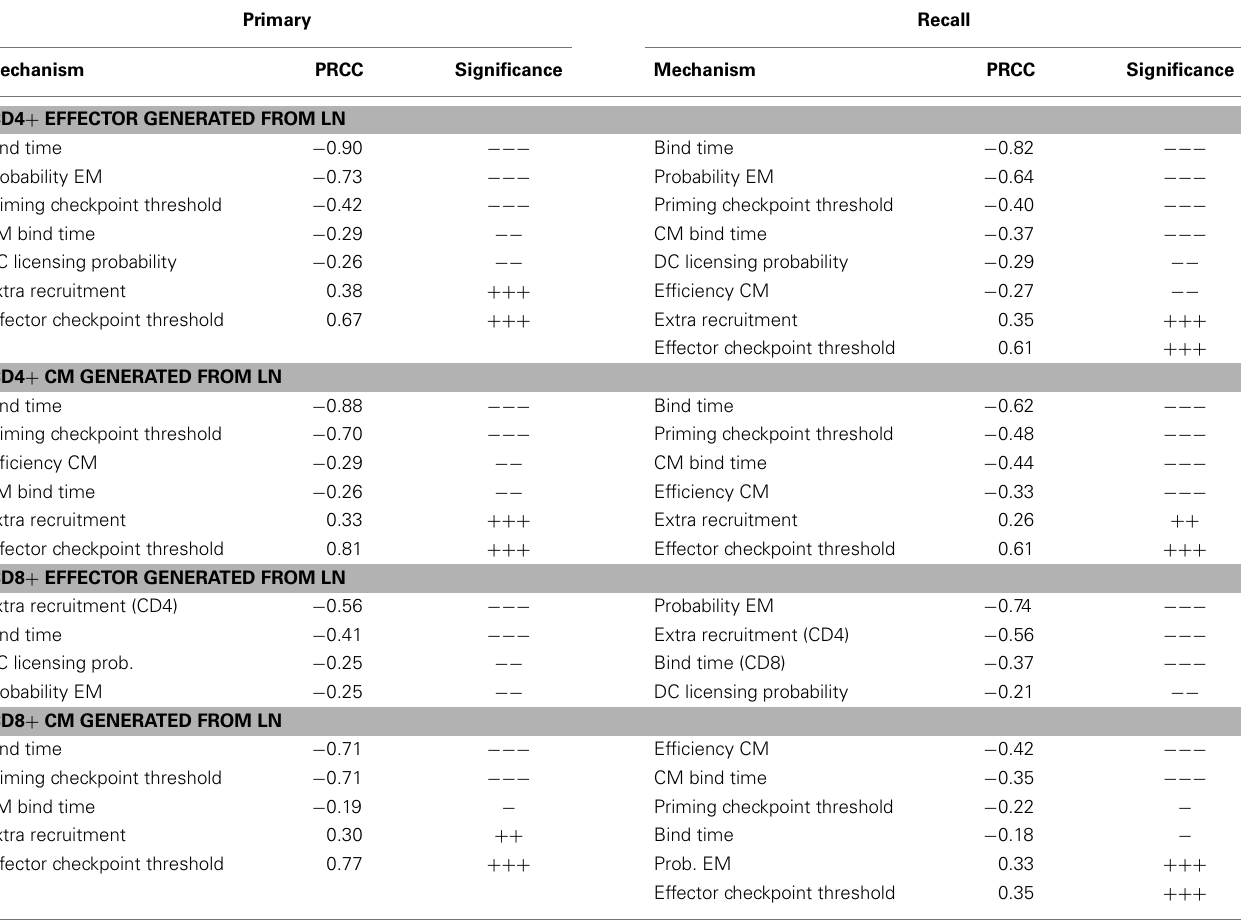
Table 1 | PRCC results: tracking sensitivity of outputs of LN cells to LN